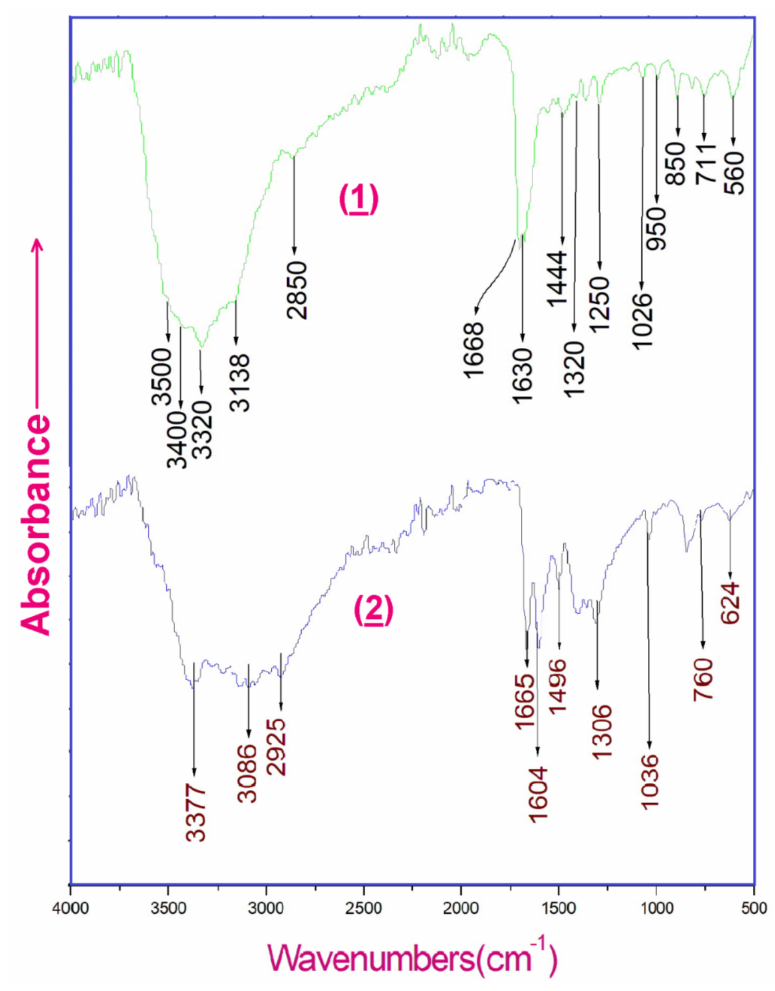
Figure 15. Experimental infrared absorption spectra of ( 1 ) and ( 2